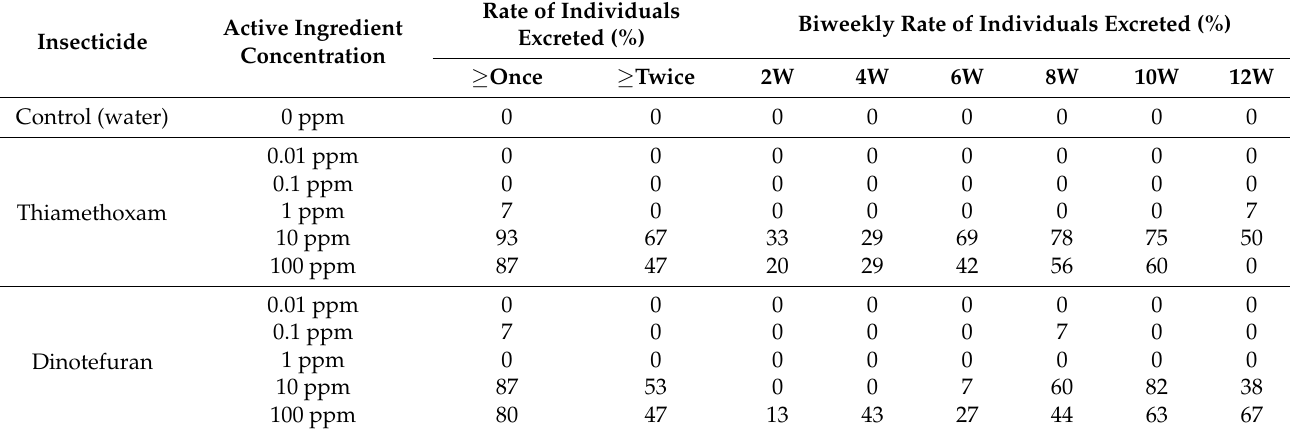
Table 2. Abnormal excretion by Aromia bungii late instar larvae in the dietary toxicity test. Active Insecticide